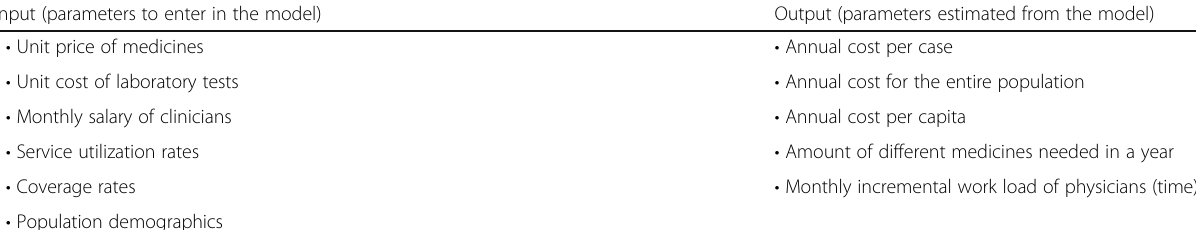
Table 1 Costing model input and output parameter estimates Input (parameters to enter in the